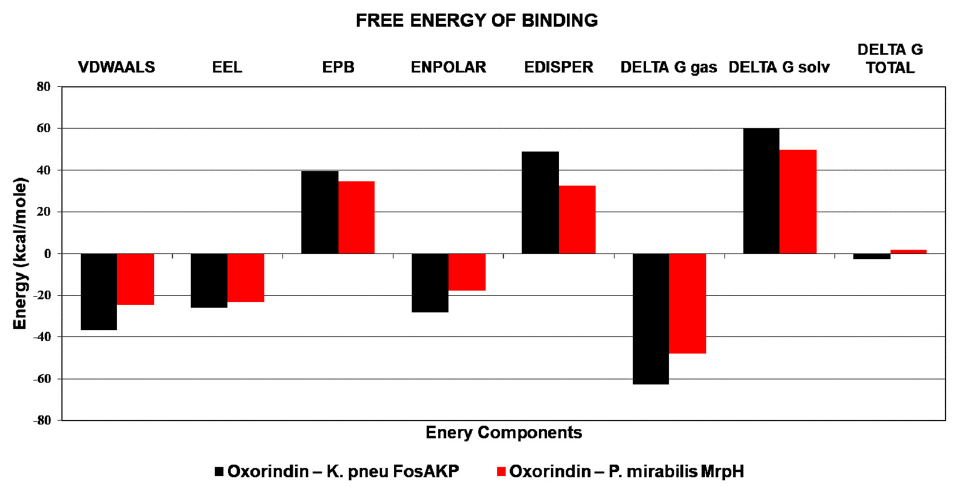
Figure 7. Binding free energy of Oroxindin in complex with 5WEW and 6Y4F.